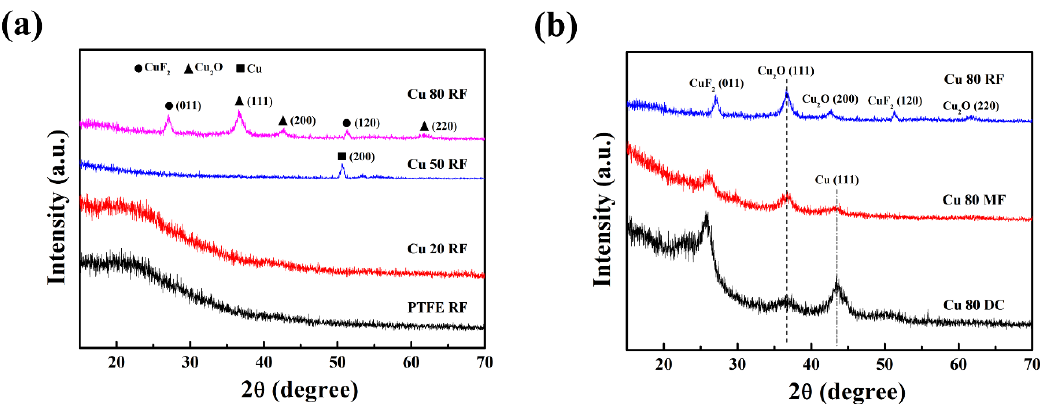
Figure 5. XRD patterns of ( a ) pure PTFE, Cu 20 RF, Cu 50 RF, Cu 80 RF, and ( b ) Cu 80 RF, Cu 80 MF, and Cu 80 DC nanocomposite thin films.